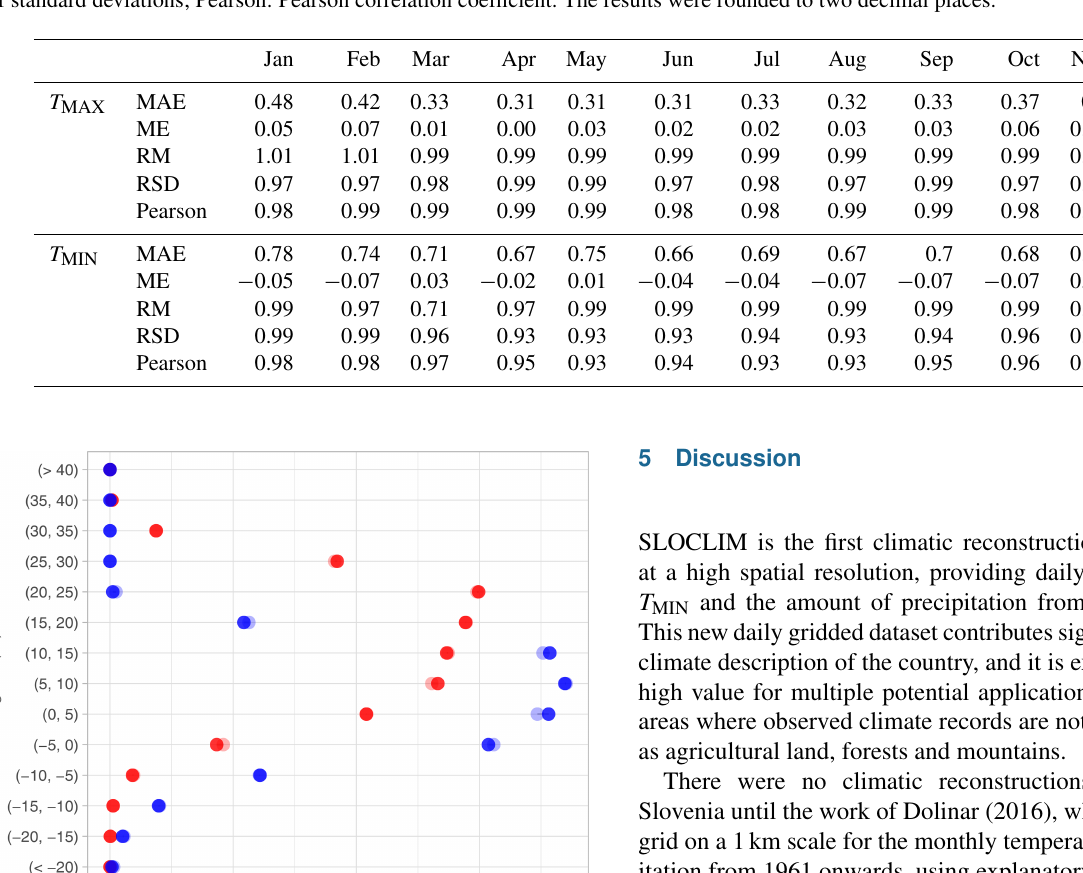
Table 5. The leave-one-out cross-validation (LOO-CV) statistics showing the goodness of fit between maximum and minimum temperature measurements and estimates of monthly aggregates. MAE: mean absolute error ( ◦ C); ME: mean error ( ◦ C); RM: ratio of means; RSD: ratio of standard deviations; Pearson: Pearson correlation coefficient. The results were rounded to two decimal places.